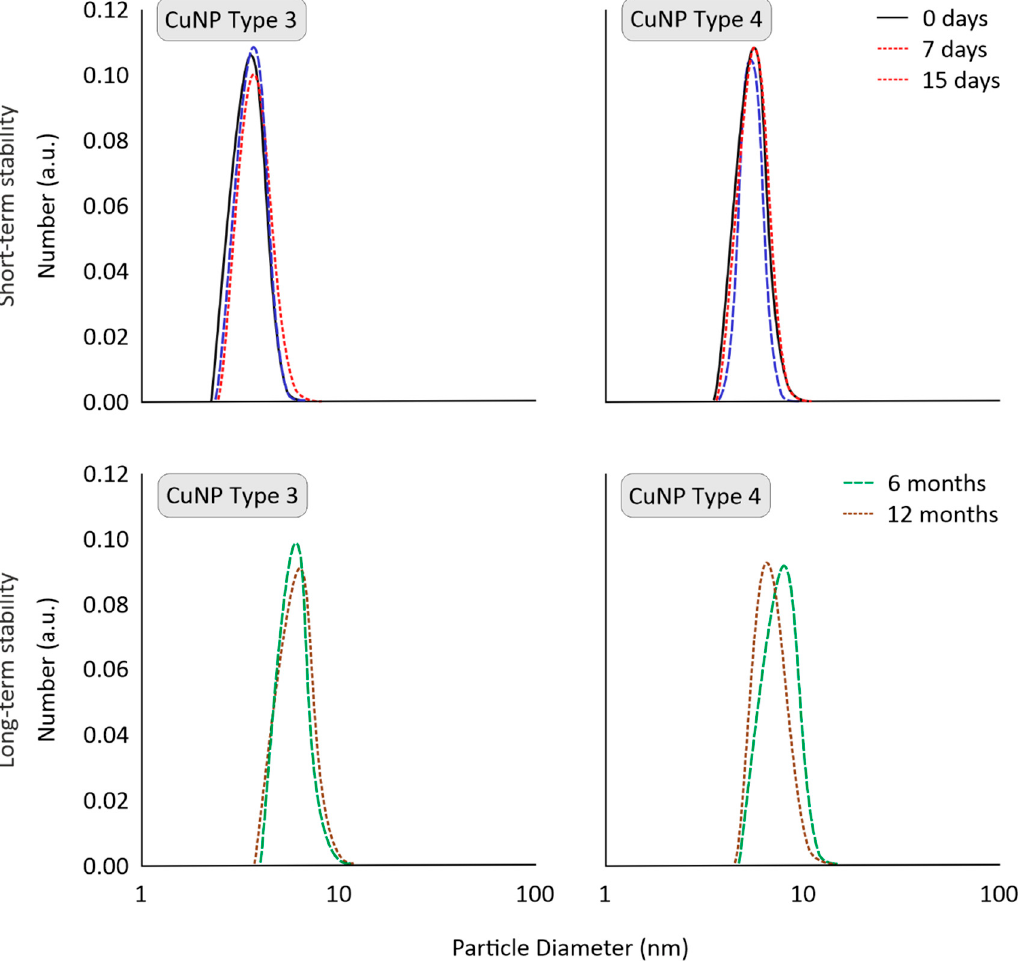
Figure 4. Short-term stability (in tap water) and long-term stability (upon storage), indicatively for CuNPs Types 3 and 4, evaluated by Dynamic Light Scattering (DLS).